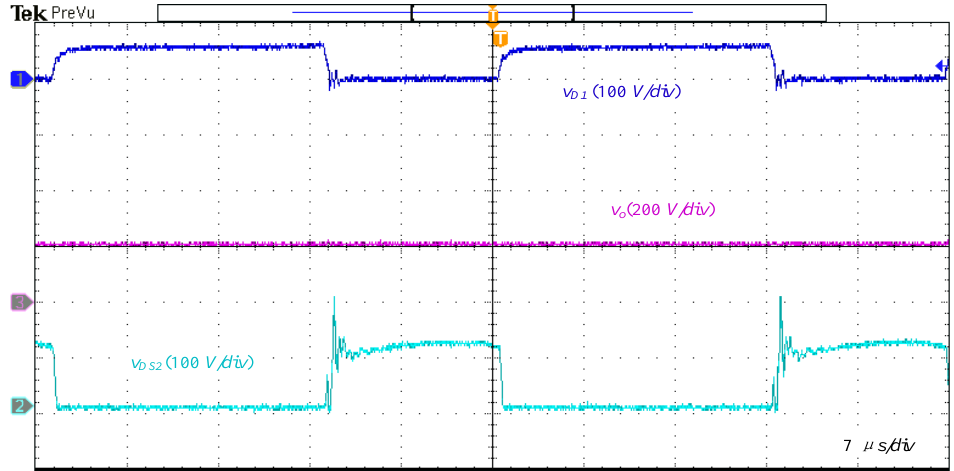
Figure 13. The output voltage, switch S 2 drain source voltage, and diode D 1 reverse voltage at an input voltage of 20 V and a duty cycle of 0.6.